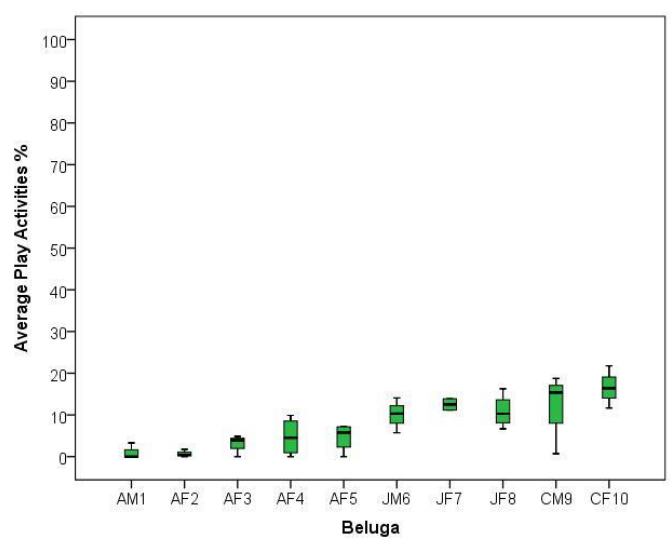
Figure 6. Boxplots of average play activities percentage per individual beluga. Note the scale is a